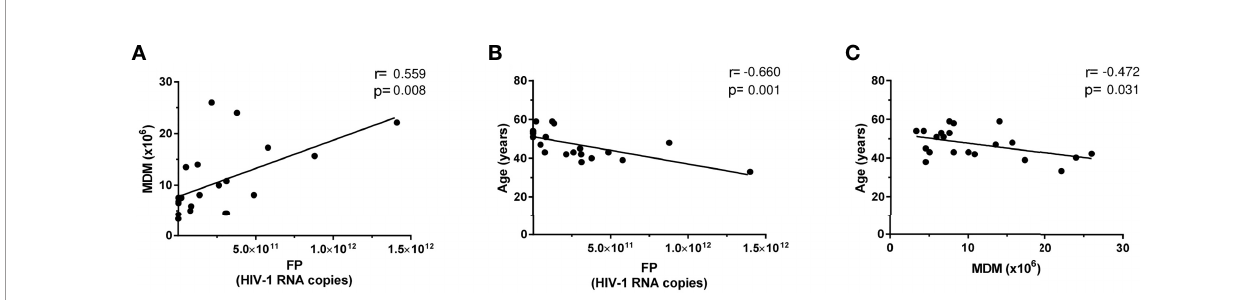
FIGURE 4 | Correlation graphs on speci fi c patient parameters. Individually depicted solid circles for each patient are graphed, showing HIV RNA copies per fi nal product (FP) versus either (A) amount of monocyte-derived macrophages (MDMs) at coculture onset or (B) patient age. (C) The correlation of MDMs at coculture onset patient age. The Pearson correlation test was always applied, and resulting fi tted regressions are represented by solid